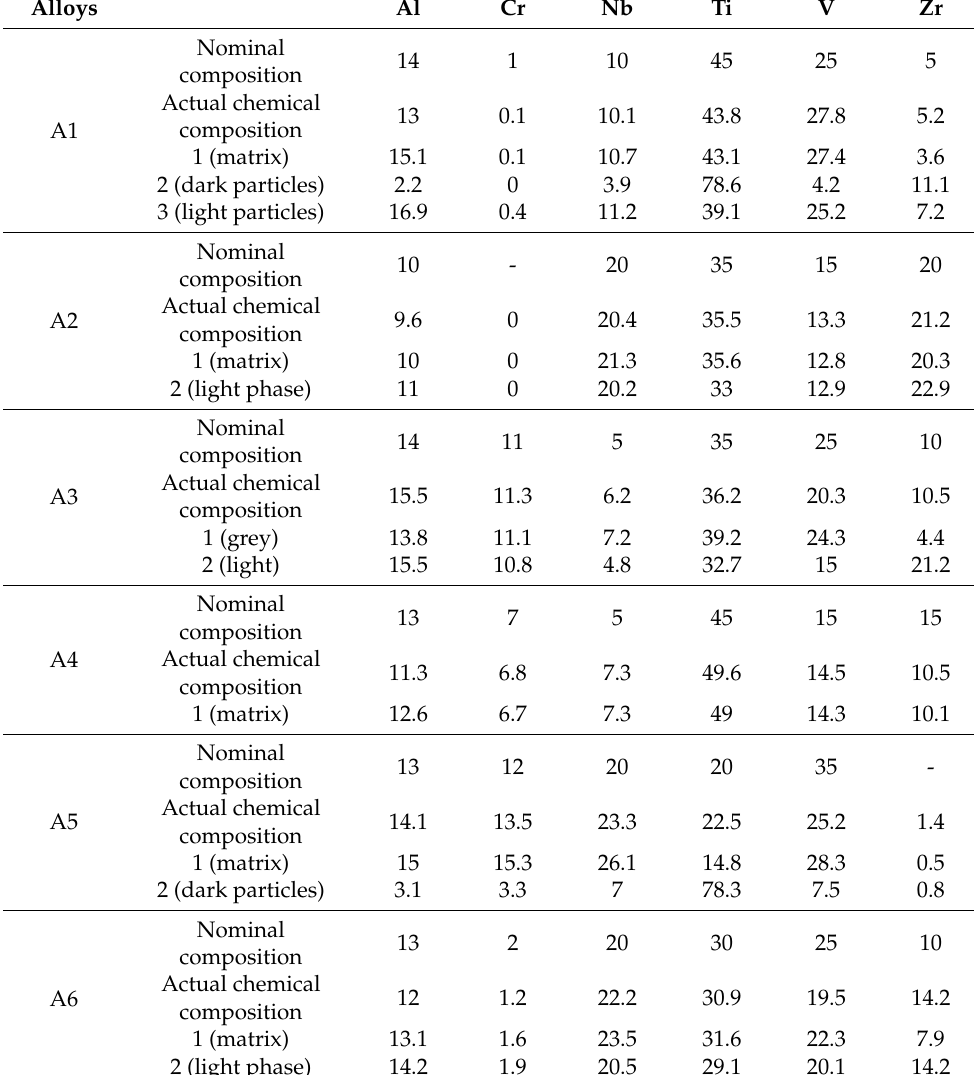
Table 3. The chemical compositions of model alloys (in at.